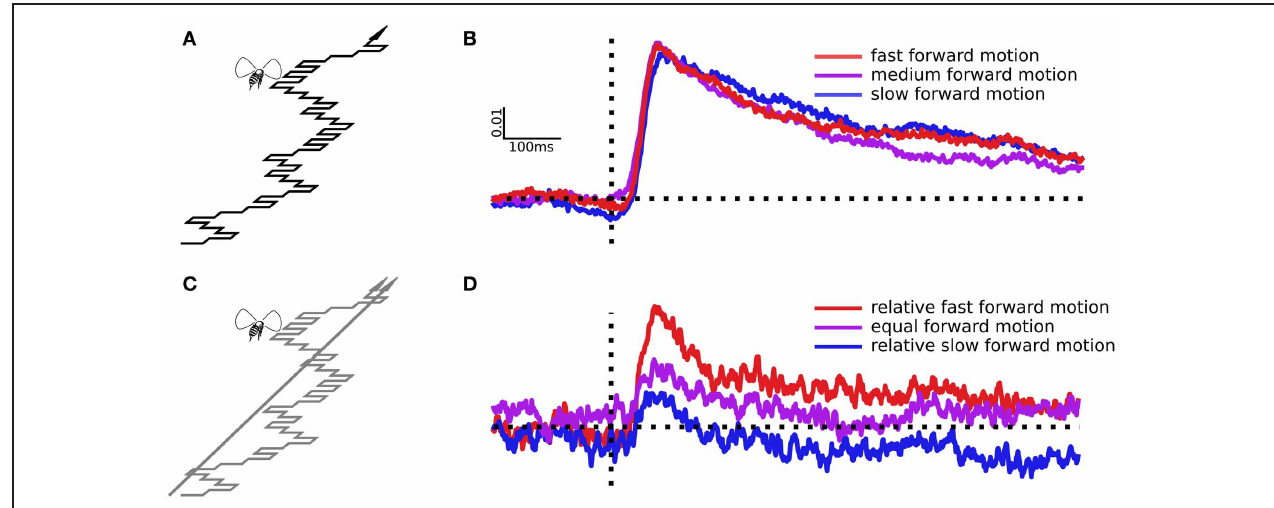
Here the dots were split, half simulating a straight ahead trajectory, half simulating sideslip following an m-sequence. (D) Impulse responses from the slipping points, which moved identically in each trial, but in the presence of three different straight ahead dot speeds, which change the relative forward speed of the slipping